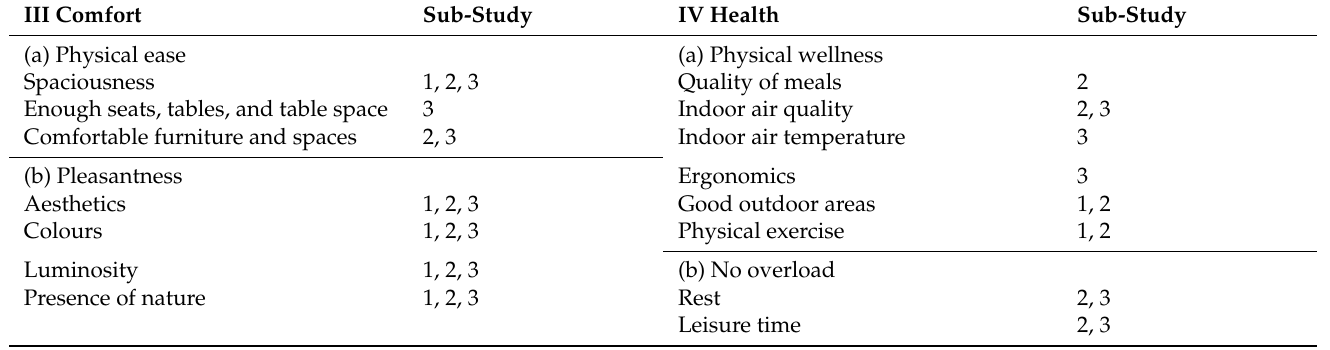
Table 3. Comfort- and health-related characteristics confirmed or emerged in sub-studies.